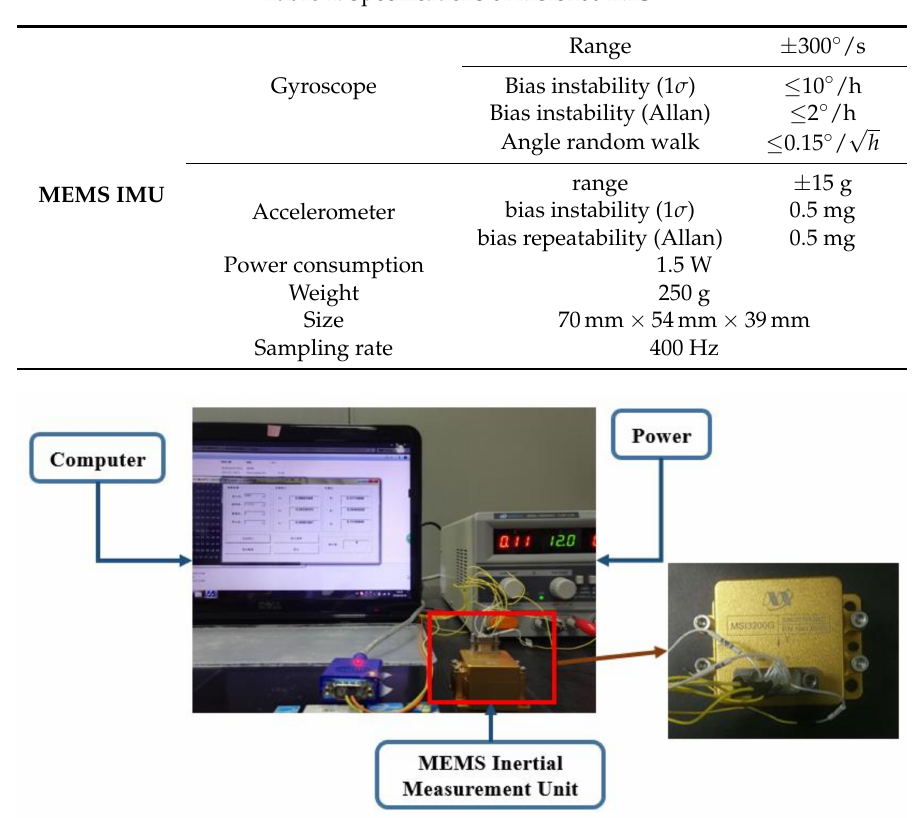
Figure 4. Gyroscope and Accelerometer raw signals collecting.